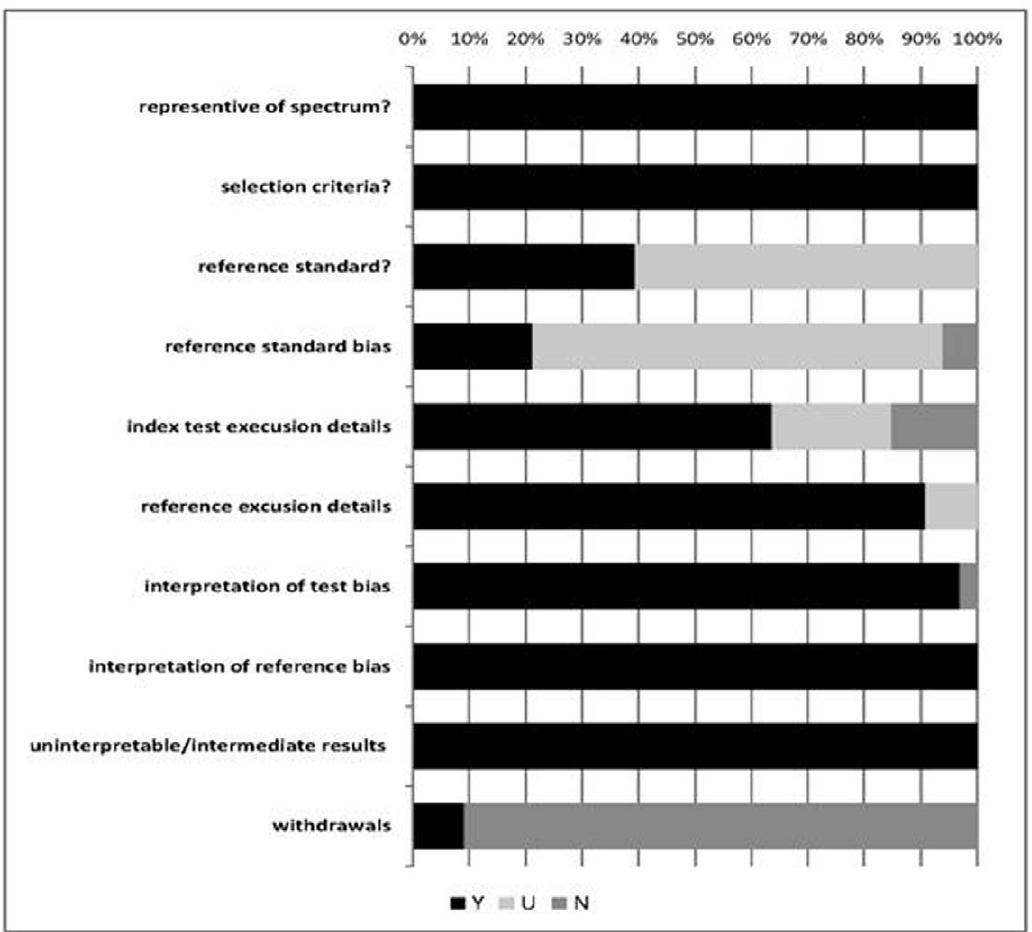
Figure 2. Assessment of quality items using modified QUADAS tool. Y=yes; U=unclear; N=no.